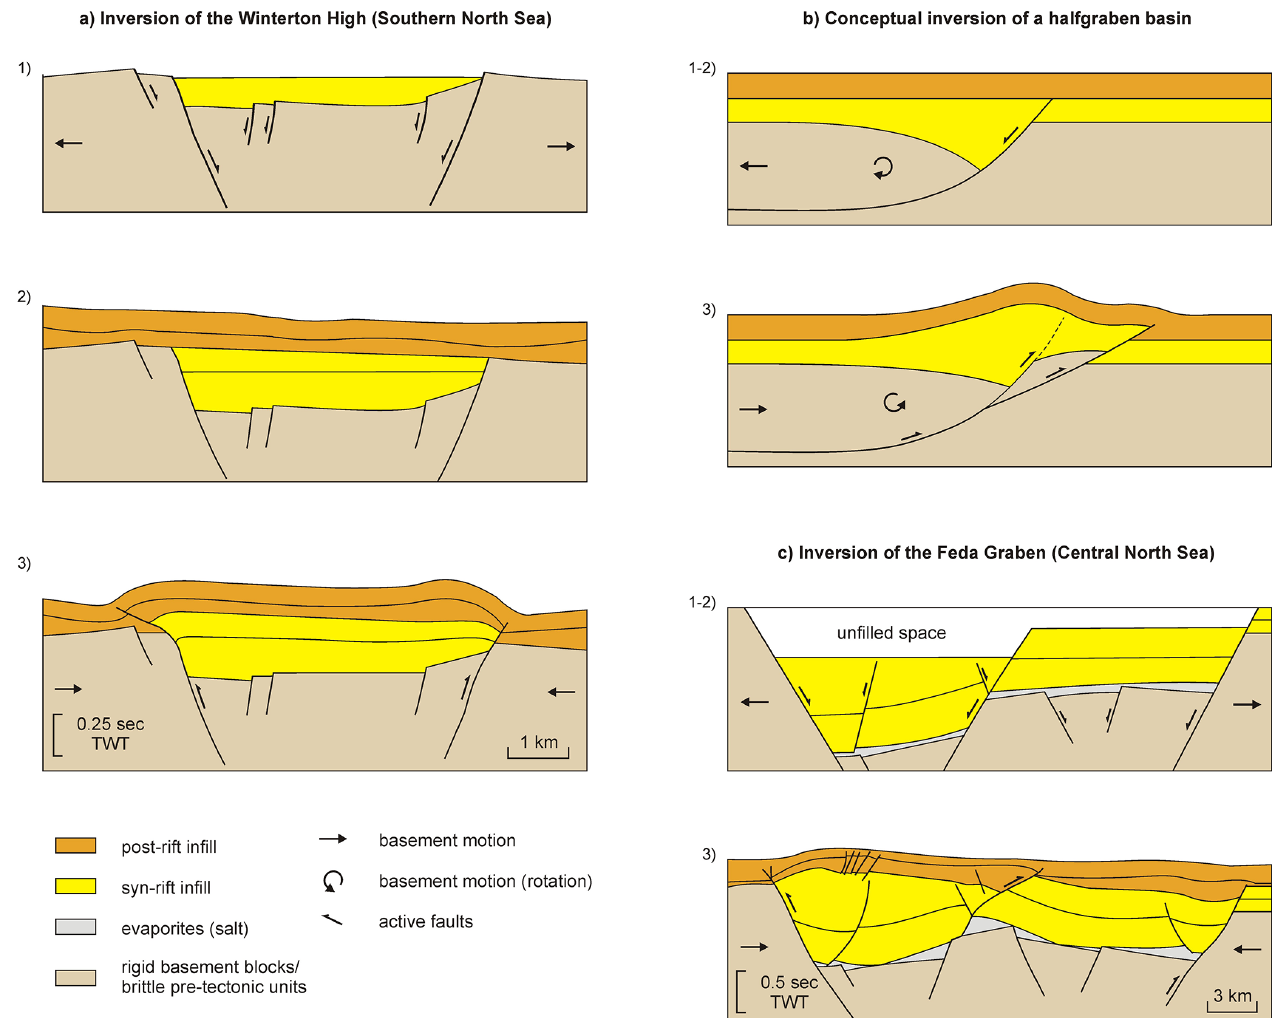
Figure 1. Schematic examples of the three main stages of basin inversion: (1) syn-rift, (2) post-rift, and (3) inversion. (a) Formation and inversion of a symmetric graben (Winterton High in the Southern North Sea), where bounding normal faults were reactivated and propagated into the overburden at a shallow angle during Cenozoic basin inversion. Redrawn after Panien et al. (2006a), based on Badley et al. (1989), with permission from the Geological Society, London. (b) Schematic example of an inverted half-graben related to a listric fault. Inversion causes uplift of the basin fill and reactivation of the listric fault that propagates upward into the previously undeformed post-rift units, as well as the development of a new thrust fault (i.e. a “footwall shortcut”). Modified after Cooper et al. (1989), with permission from the Geological Society, London. (c) Simplified development of the salt-bearing Feda Graben in the central North Sea. The salt (Upper Permian Zechstein evaporites) decouples the basin infill from the basement. Based on Gowers et al. (1993) and Stewart and Clark (1999), with permission from the Geological Society, London. TWT stands for two-way travel